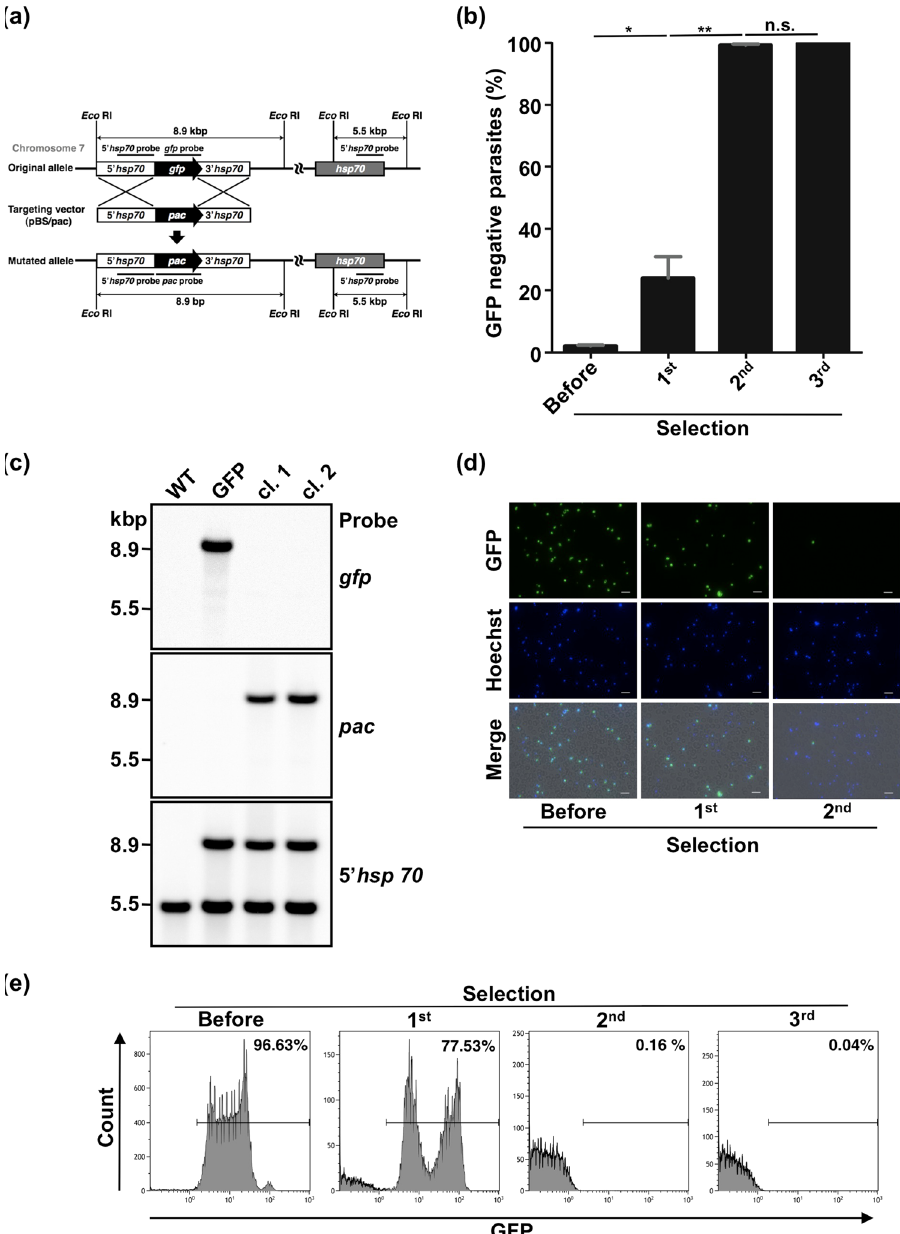
Figure 3. Generation of mutants using the pac marker by double-crossover homologous recombination. ( a ) Schematic diagram showing the targeting of gfp by pac through double crossover homologous recombination. ( b ) GFP negative parasite ratio after each puromycin selection. The ratio was analyzed using fluorescence microscopy. Each bar represents the mean ± SD of three independent experiments. ** p < 0.01, * p < 0.05, n.s.: not significant (paired t -tests). ( c ) Southern blot analyses of two independent clones. Genomic DNA was digested with Eco RI and hybridized with gfp , pac , and 5 ′ hsp70 probes. The predicted sizes of restriction fragments are shown. WT: wild type, GFP: GFP-expressing parasite (parental line), cl.: clone. Full-length blot images are presented in Supplementary Figure S2. ( d ) Fluorescence images of parasites after each selection. Parasites were stained with Hoechst 33342. The scale bar represents 10 µ m. ( e ) Flow cytometry analysis of GFP positive mutant ratio after each puromycin selection. Numbers above bracketed lines indicate percent parasites with GFP